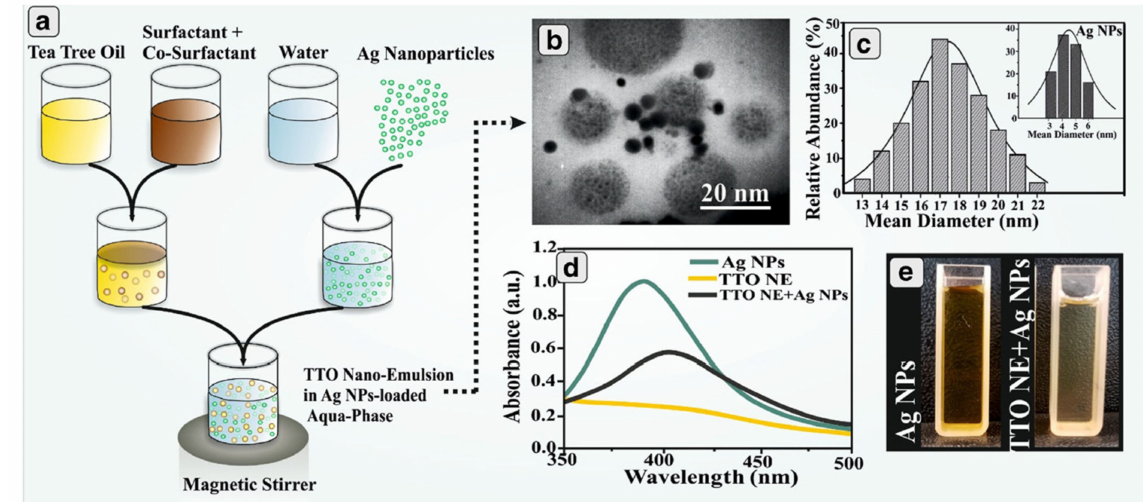
Figure 4. Schematic illustration of preparation procedure of TTO NE + Ag NPs ( a ), Transmission electron micrograph and size distribution of TTO NE and Ag NPs as inset ( b , c ). UV–Vis spectroscopy of TTO NE + Ag NPs and Ag NPs, as well as TTO ( d ). Optical images of Ag NPs and TTO NE + Ag NPs ( e ). Reproduced with permission from [120], AAPS PharmSciTech,